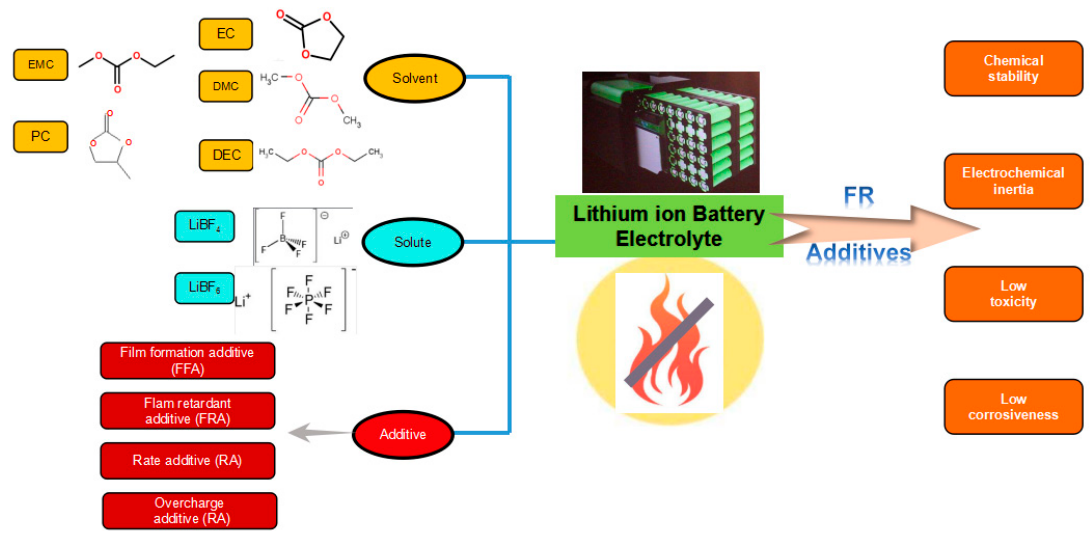
Figure 9. The common constitutes of LIB electrolytes and the requirement of FR additives.